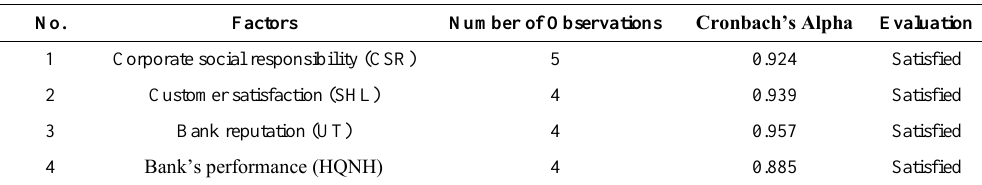
Table 3. Summary of